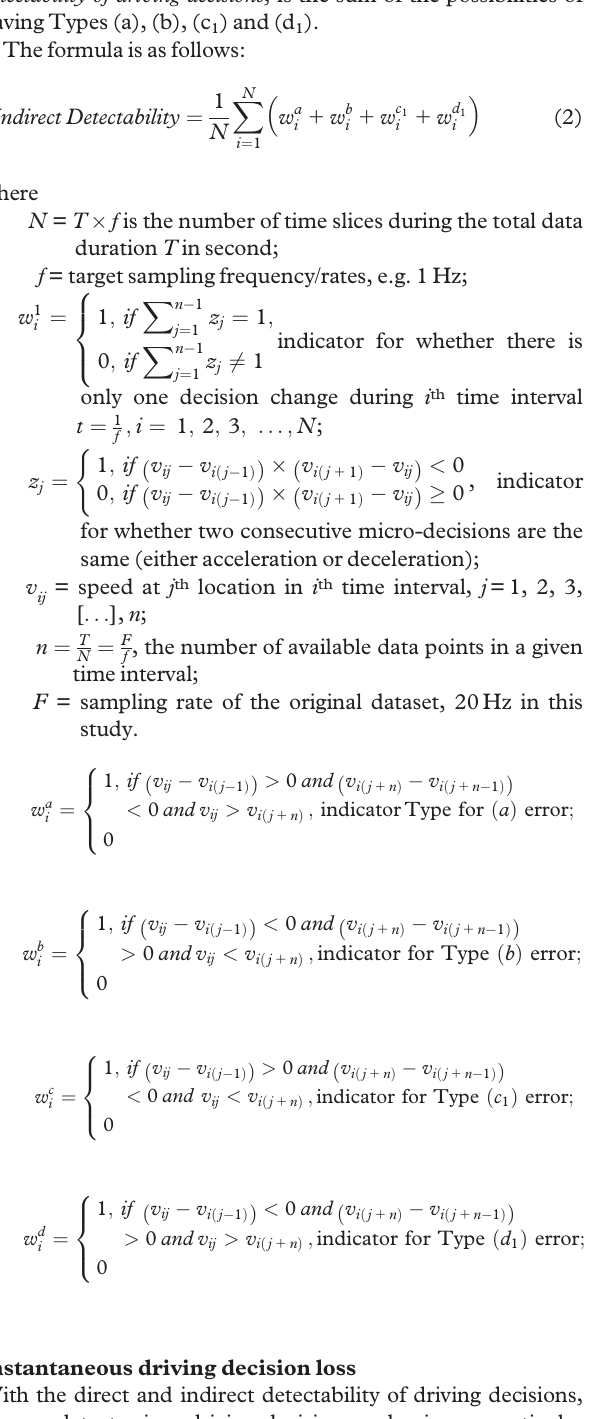
An indicator of information loss is through speed deviations. The deviations are measured based on the linear distance between observed speeds and sampled